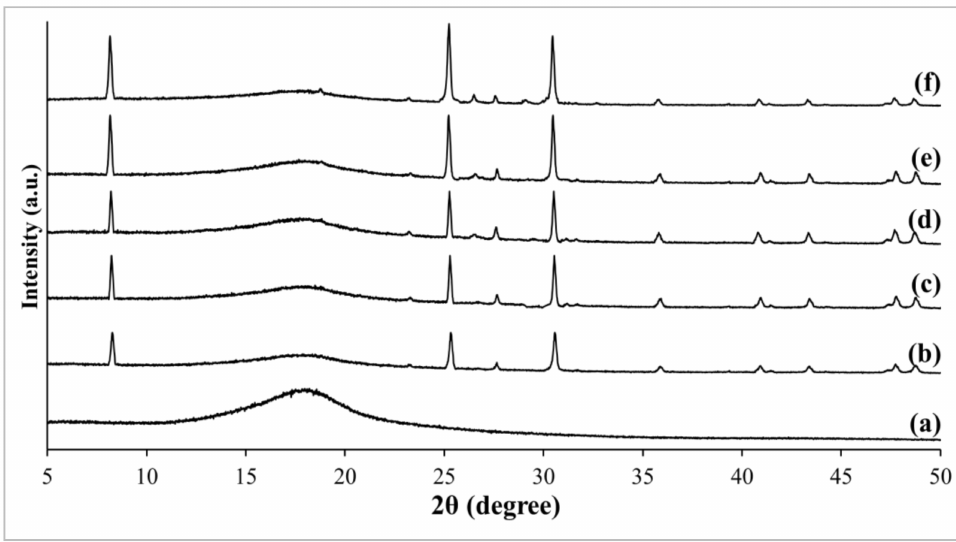
Figure 3. XRD patterns of (a) pristine PSf membrane, (b) 1RHO/PSf, (c) 2RHO/PSf, (d) 3RHO/PSf, (e) 4RHO/PSf, and (f) 5RHO/PSf MMMs.